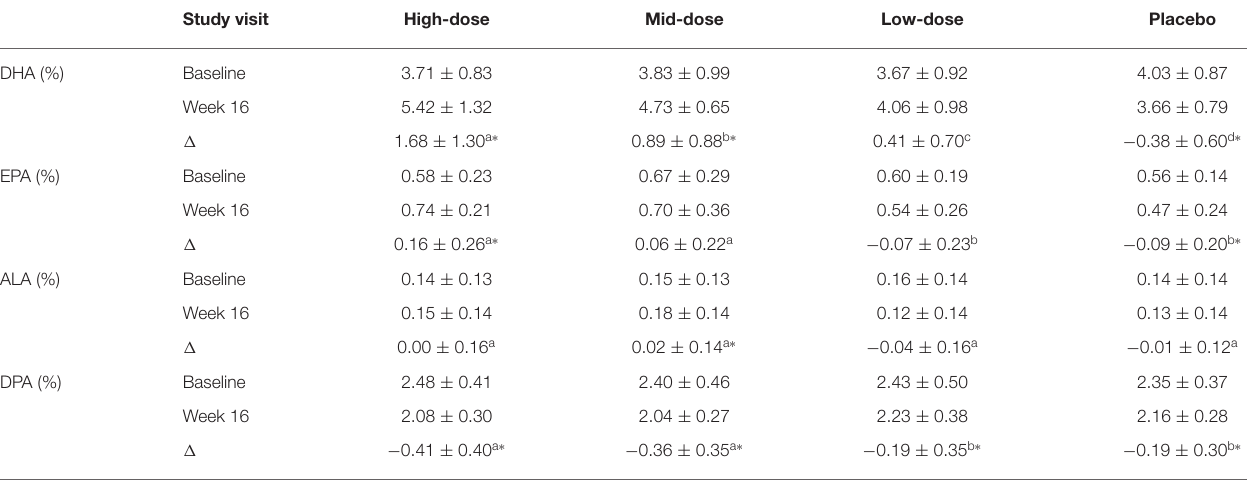
Values are means ± SD. Red blood cell ω 3 profile parameter changes were analyzed using ANCOVA with treatment and smoking status as fixed effects, and the baseline parameter value as a covariate. P baseline was < 0.01 for all parameters, P treatment was < 0.01 for all parameters except ALA, and P smoking was only < 0.05 for ALA. Values without a common letter (a, b, c, d) indicate significant between-group differences (P < 0.05). *Indicates significant within-group change from baseline to week 16 (P < 0.05). At baseline, n = 31, 30, 31, and 33 for high-dose, mid-dose, low-dose, and placebo groups; at week 16, n = 29, 30, 28, and 32 for high-dose, mid-dose, low-dose, and placebo groups, respectively. ALA,